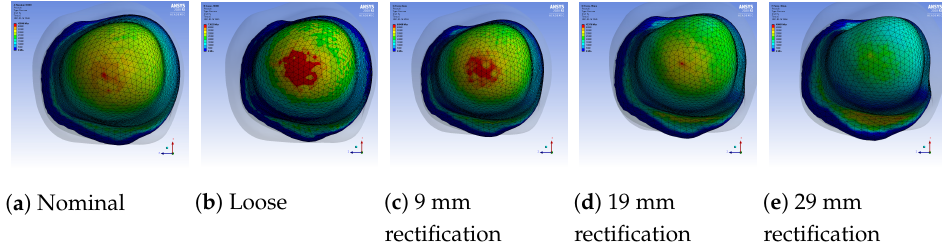
Figure 11. Regional pressure values in the distal-end region of the stump for different sockets.